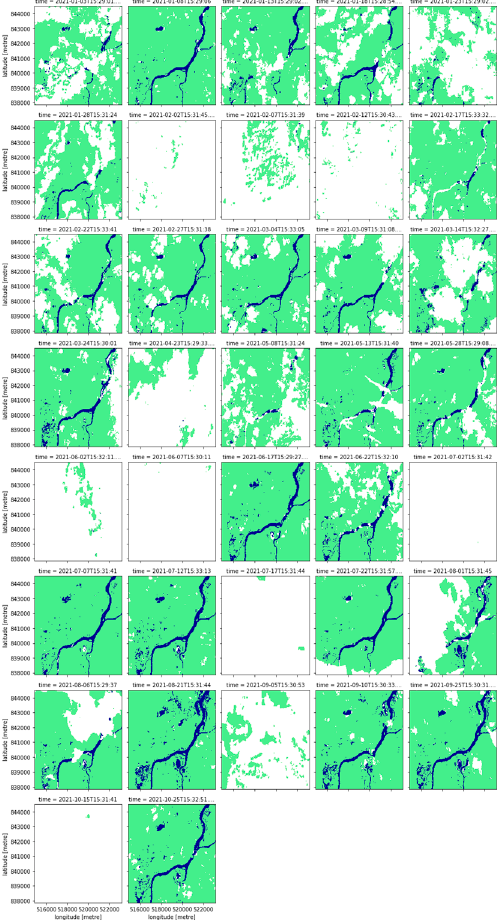
Figure 2. Water classification results over the period 1 January 2021/31 October 2021 around the town of El Bagre showing variability in Sentinel-2 image quality. Results are classified as follows: blue = water; green = not water, and white = pixel removed by the clean mask for the